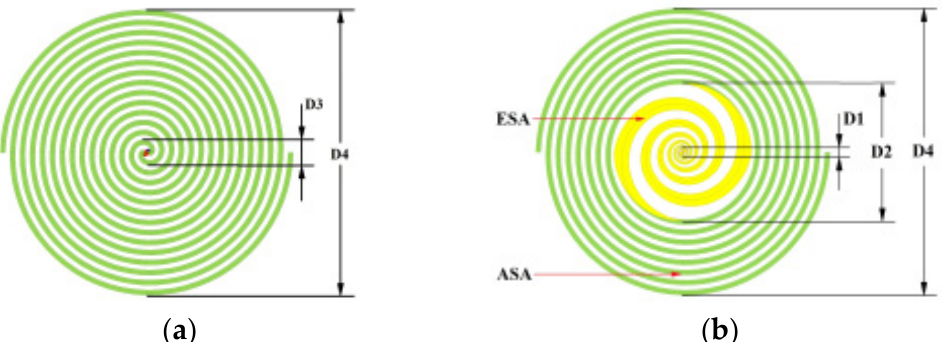
Figure 18. The ( a ) Archimedean spiral antenna, and ( b ) Planar complex spiral antenna proposed in [123].